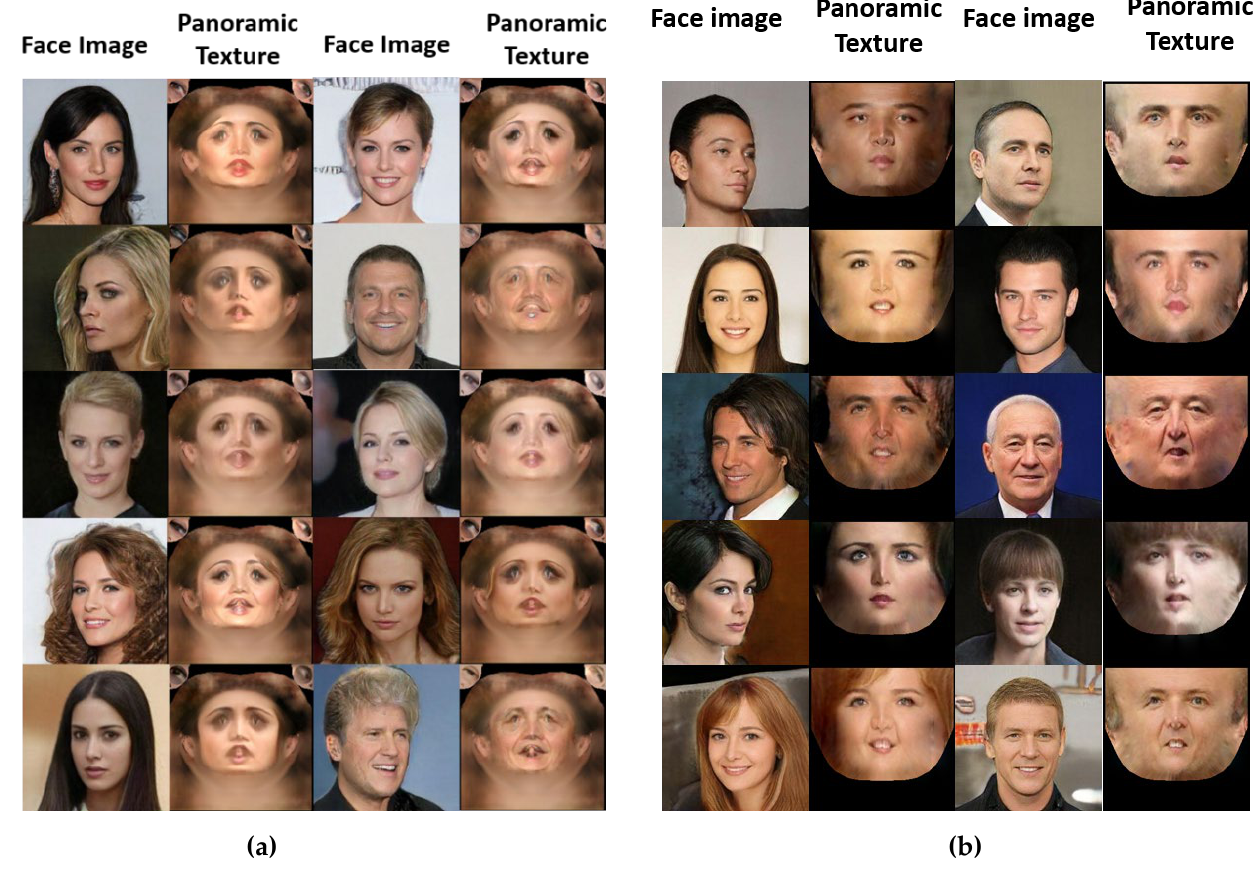
Figure 12. Panoramic texture synthesis result. ( a ) Some sample texture synthesis result based on the FLAME model and ( b ) Some sample texture synthesis result based on the BFM model.